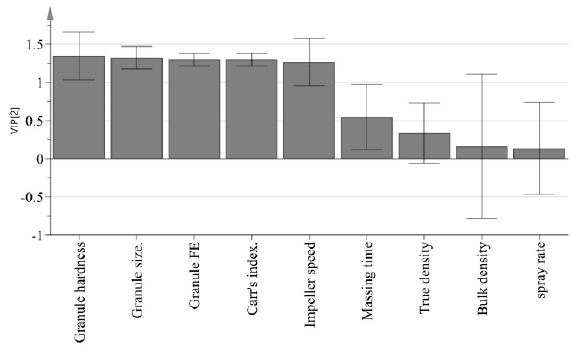
Figure 9. VIP (variable importance) plot presenting very important variables in terms of